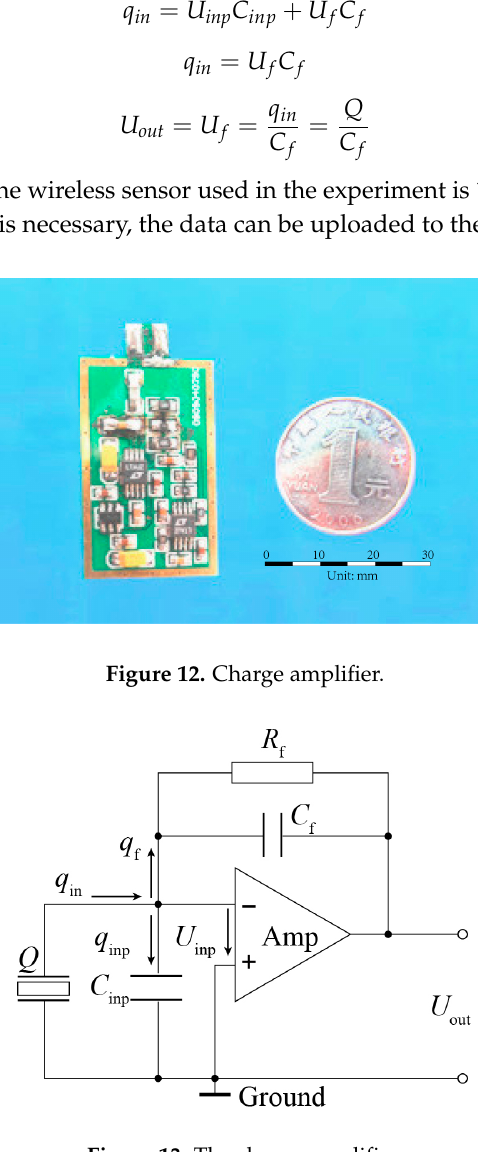
Figure 13. The charge amplifier.